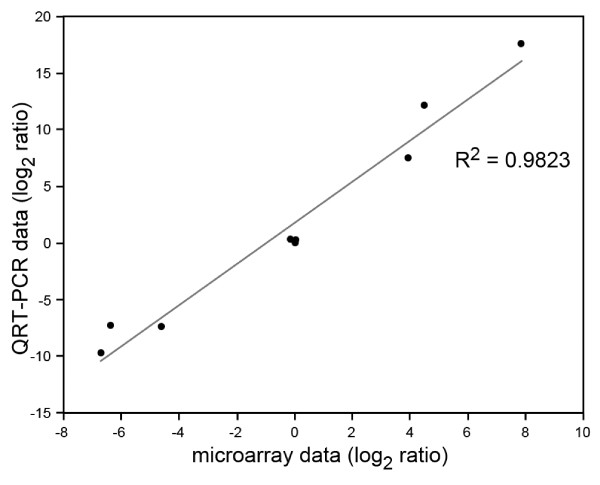
Correlation between qRT-PCR and microarray results. A statistically significant correlation (r = 0.9823, p = 2.376e-06) was obtained for all tested genes.